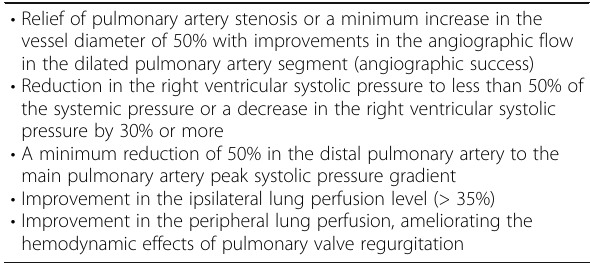
Table 3 The goal of the treatment (criteria for success) [15] (cid:129) Relief of pulmonary artery stenosis or a minimum increase in the vessel diameter of 50% with improvements in the angiographic flow in the dilated pulmonary artery segment (angiographic success) (cid:129) Reduction in the right ventricular systolic pressure to less than 50% of the systemic pressure or a decrease in the right ventricular systolic pressure by 30% or more (cid:129) A minimum reduction of 50% in the distal pulmonary artery to the main pulmonary artery peak systolic pressure gradient (cid:129) Improvement in the ipsilateral lung perfusion level (> 35%) (cid:129) Improvement in the peripheral lung perfusion, ameliorating the hemodynamic effects of pulmonary valve